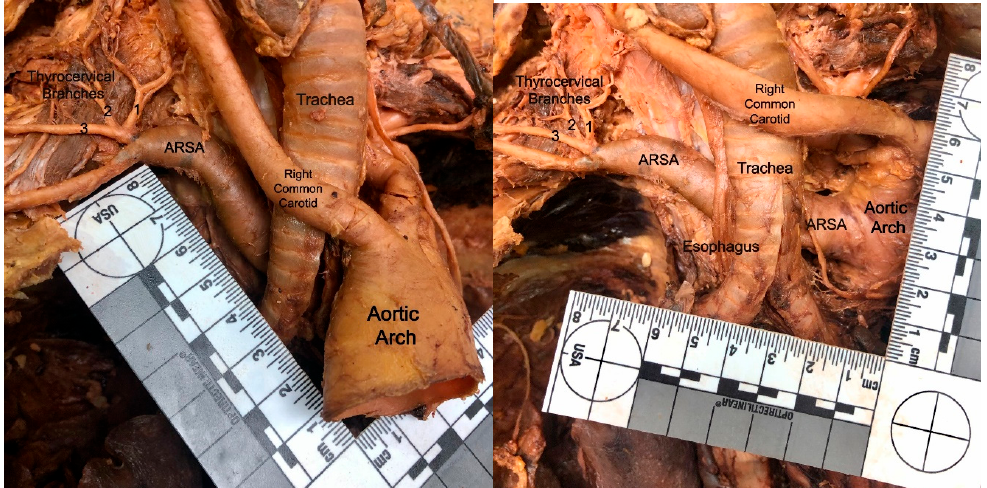
Figure 1. Dissection photo (left) showing the aberrant right subclavian artery (ARSA) of cadaver #1 (female), as it courses posterior to the esophagus and trachea. Dissection photo (right) shows the branching point of the aberrant right subclavian artery (ARSA), of cadaver #1 (female), from the posterior surface of the aortic arch. The aortic arch was retracted laterally to the left to gain this view.